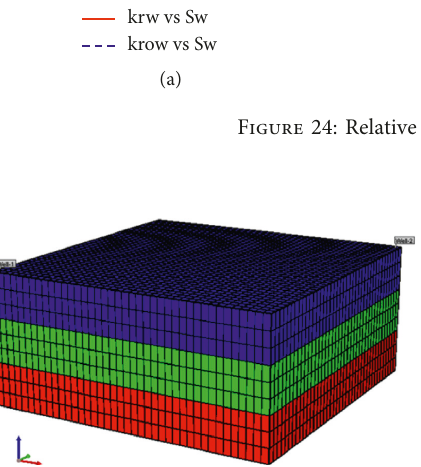
Figure 25: The numerical simulation model.